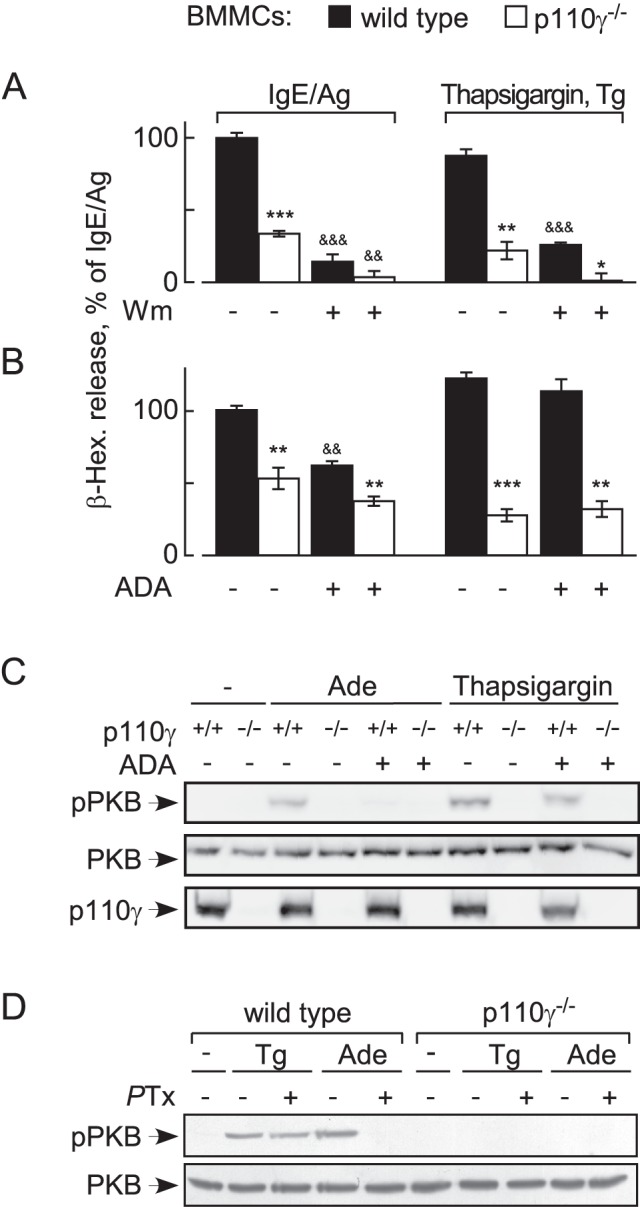
Thapsigargin-induced mast cell degranulation requires PI3Kγ, but not GPCR signaling.(A) Granule release of wild type and p110γ−/− BMMCs was determined detecting β-hexosaminidase (β-Hex) release into extracellular media. BMMC stimulation with IgE/antigen was initiated with the antigen (Ag, DNP-HSA at 10 ng/ml; 100 ng/ml IgE overnight). Alternatively, BMMCs were stimulated by the addition of thapsigargin (1 µM). Where indicated, BMMCs were preincubated for 15 min with 100 nM wortmannin. Released β-Hex was quantified 20 min after stimulation, and is expressed as mean ± standard error of the mean (SEM) (n = 3; p-values in all figures are * or &: p<0.05, **: p<0.005; ***: p<0.0005; * depict here comparison with respective wild type control; & refer to comparison of untreated versus treated samples). (B) Granule release was assessed as above, but ADA (10 units/ml) was added to BMMC suspensions 1 min before stimulation where depicted. (C) Wild type or p110γ−/− BMMCs were stimulated with adenosine (Ade; 1 µM) or thapsigargin (1 µM) for 2 min, and phosphorylation of PKB/Akt on Thr308 (pPKB), total PKB and p110γ was analyzed by Western blotting. BMMCs were incubated in starving medium (2% FCS, without IL-3) for 3 h before stimulation, and pretreated with ADA where indicated. (D) Heterotrimeric Gαi proteins were inactivated by preincubation of wild type and p110γ−/− BMMCs with 100 ng/ml PTx for 4 h, before thapsigargin (Tg) or adenosine was added as in (C).